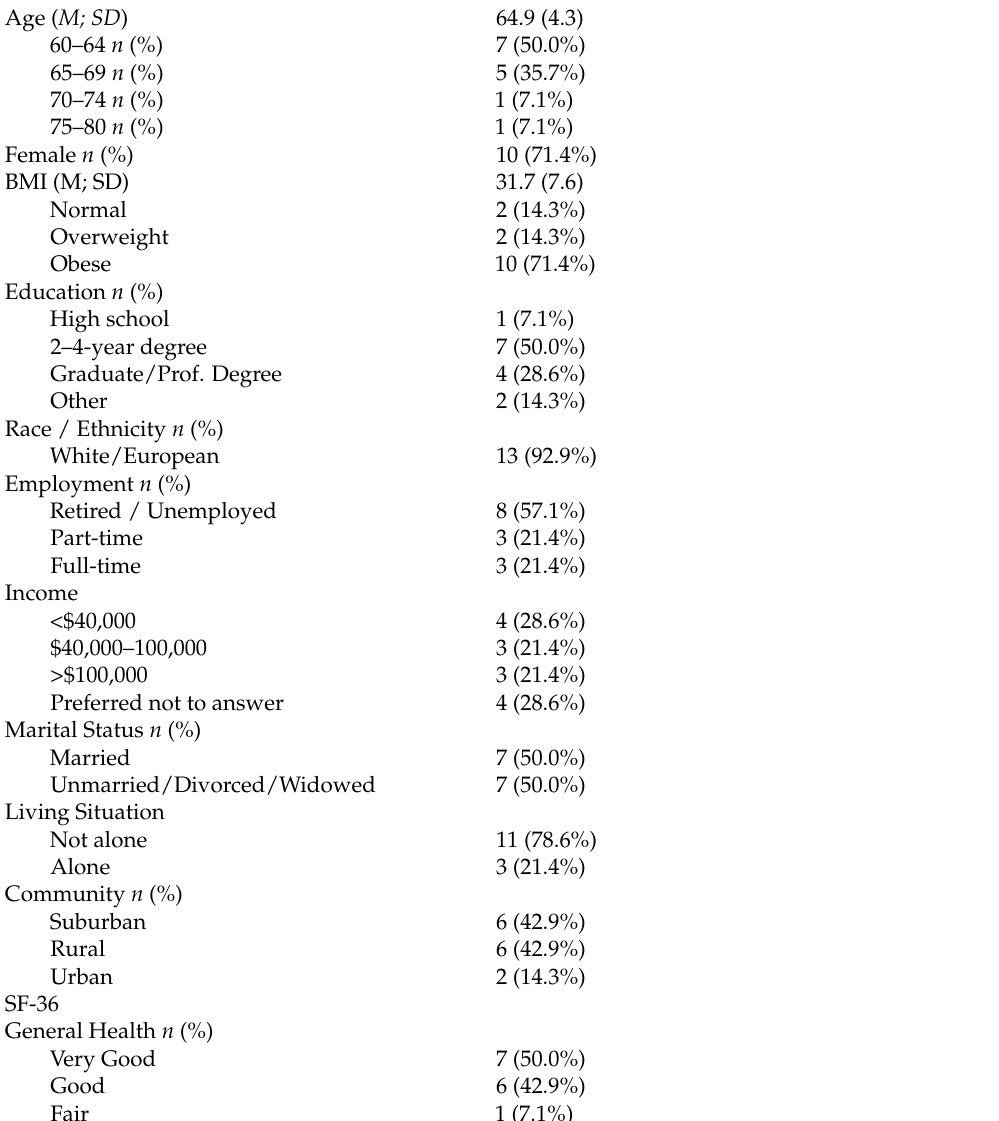
Table 1. Participant Characteristics ( n